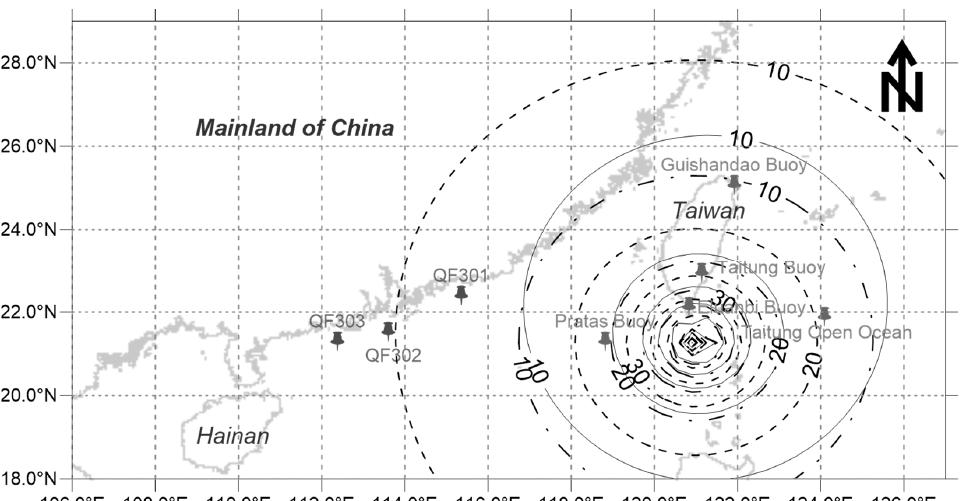
Figure 6. Wind fields (unit as m/s) restructured by MH10 (asymmetric structure as solid line, B3-A1-A2); standard H10 (axis-symmetric structure as a dashed line, B2-A1-A1); and the varying scaling parameter b s without asymmetric structure (depicted with the dashed ‒ dotted line, B3-A1-A1) at Eluanbi Station peak wave time during Typhoon Meranti (142016).